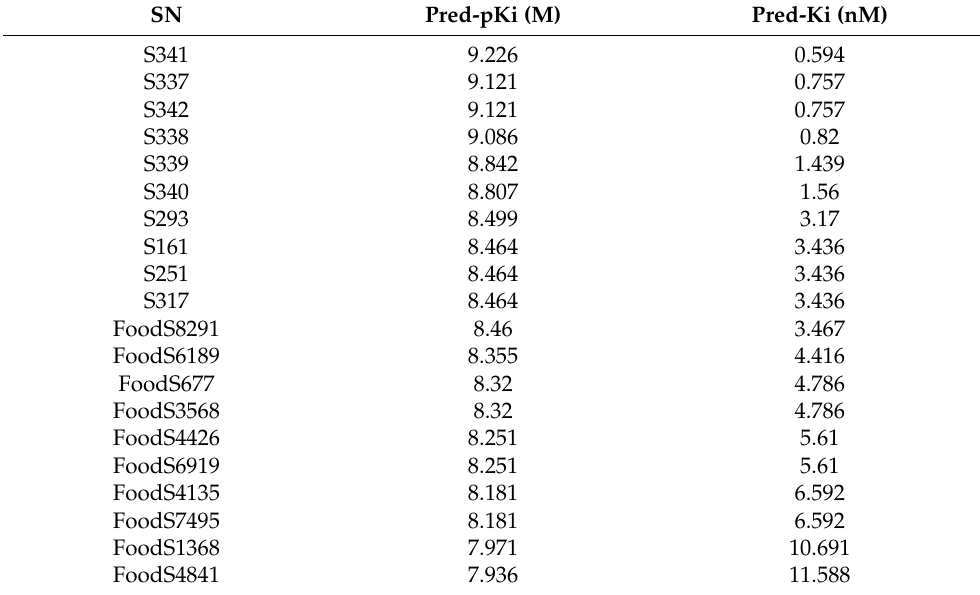
Table 1. Predicted (Pred) pKi and Ki for different variants of molecule 1 (#1 to 10) and food com- pounds (#11 to 20) used for QSAR-based virtual